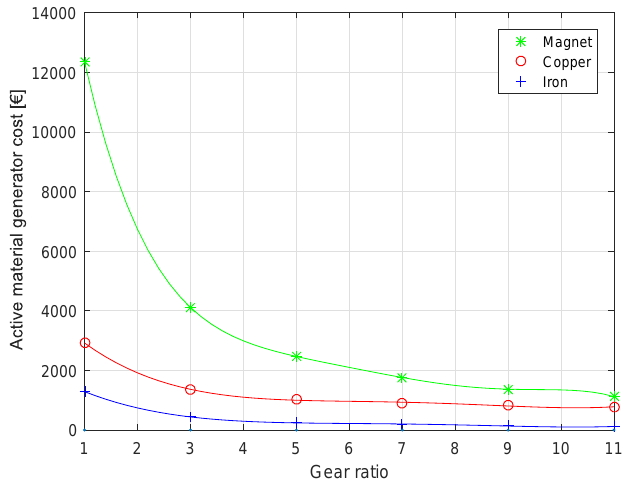
Figure 17. Generator active materials cost for different gear ratios at the power rating of 1.5 MW.